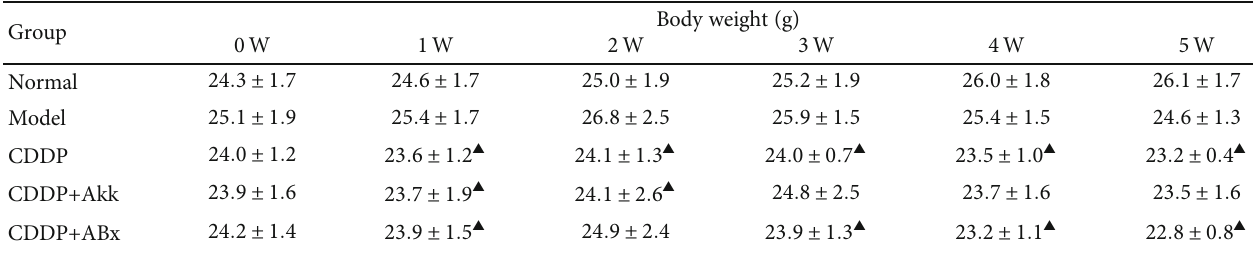
Table 1: Body weight of mice ( mean ± SD , n = 10 ).